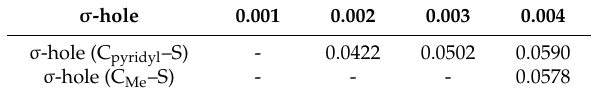
Table 2. V S,max (au) calculated on the S σ -holes in conformer 1 -A2 at isodensity surfaces 0.001 − 0.004